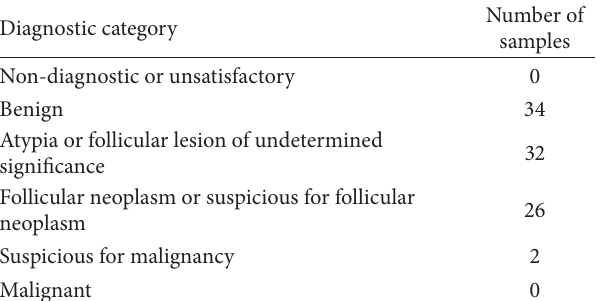
Table 2: Stratification of fine needle aspiration biopsies according to Bethesda